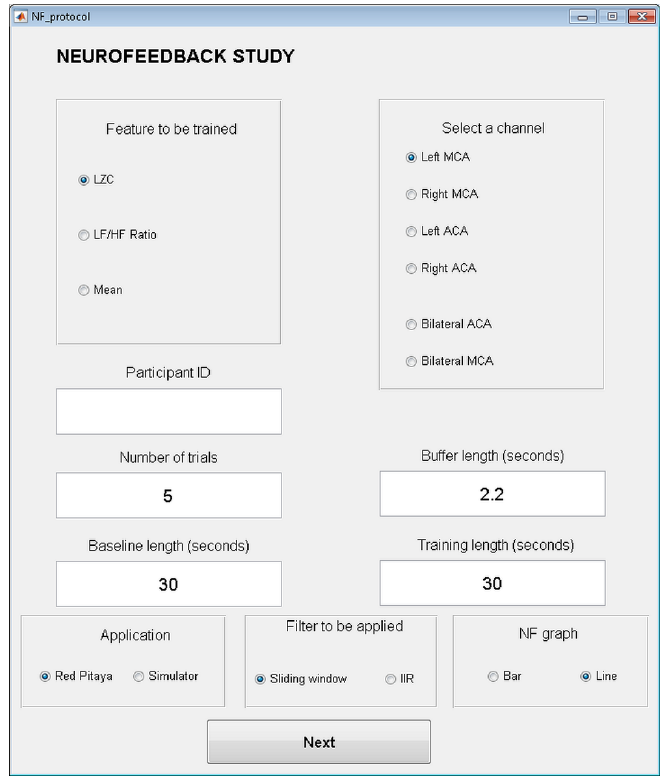
Figure 3. Configuration screen of the neurofeedback application.